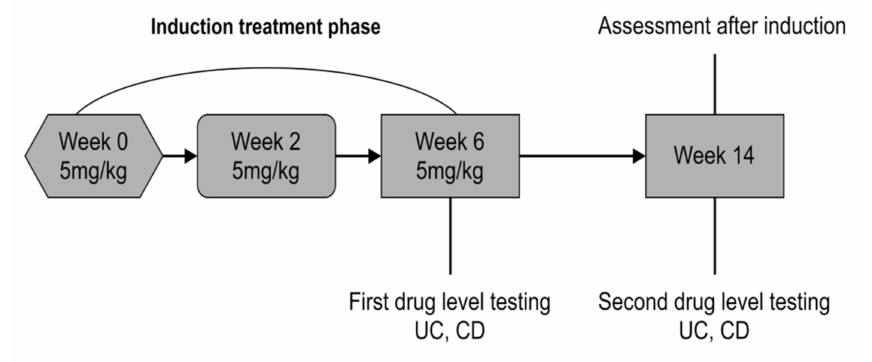
Figure 2. CT-P13 dosing and drug level testing schedule in group